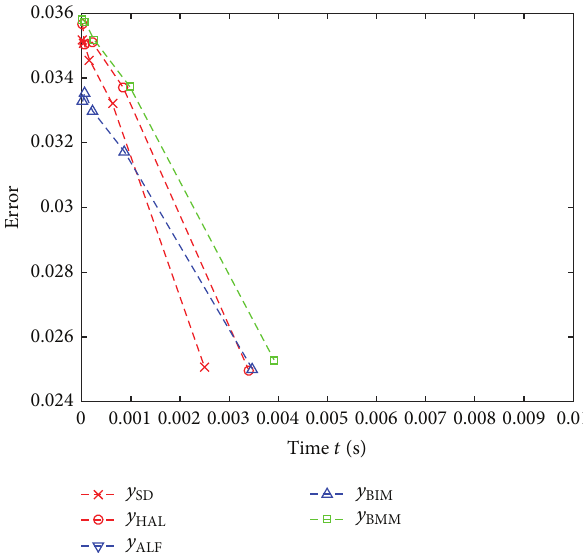
Figure 2: Strong convergence error of the mean-reverting CEV pro- cess(2)asafunctionofCPUtime(insec)usingpositivitypreserving schemes SD, HAL, ALF, BIM, and BMM with (𝑥 0 ,𝑘 1 , 𝑘 2 ,𝑘 3 ,𝑞,𝑇) = (1/16, 100, 0.05,1/16, 1,0.4,3/4,